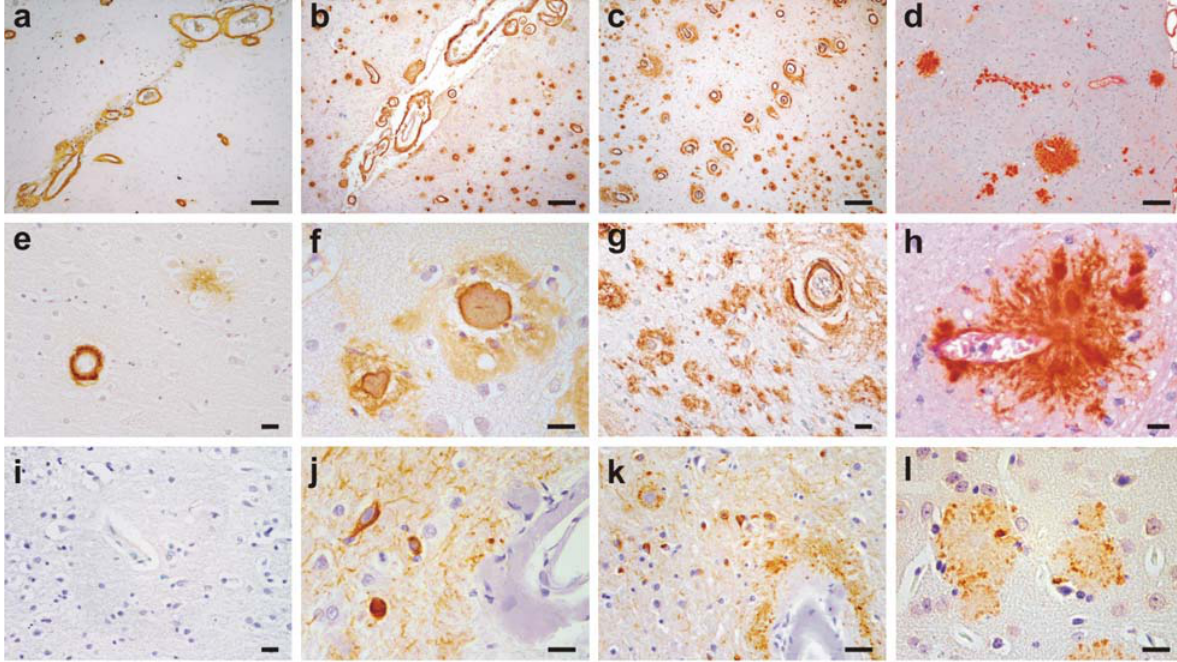
Figure 2. Spectrum of disease from primarily hereditary amyloidosis of Dutch and Flemish type to familial forms of Alzheimer’s disease (AD) and to mouse models of